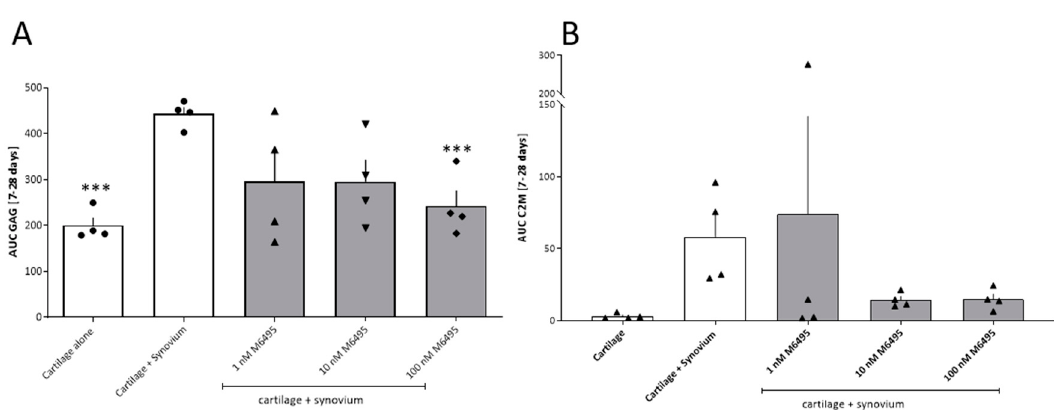
Figure 5. Cartilage turnover in bovine cartilage explants in co-culture with bovine synovial membrane. ( A ): The AUC of glycosaminoglycan (GAG) release during culture (day 7 to 28). ( B ): MMP-derived type II collagen degradation (C2M) during culture (day 7 to 28). Statistical significance was tested by one-way ANOVA with Dunnett’s multiple comparisons test comparing to cartilage + synovium.; *** p < 0.001.